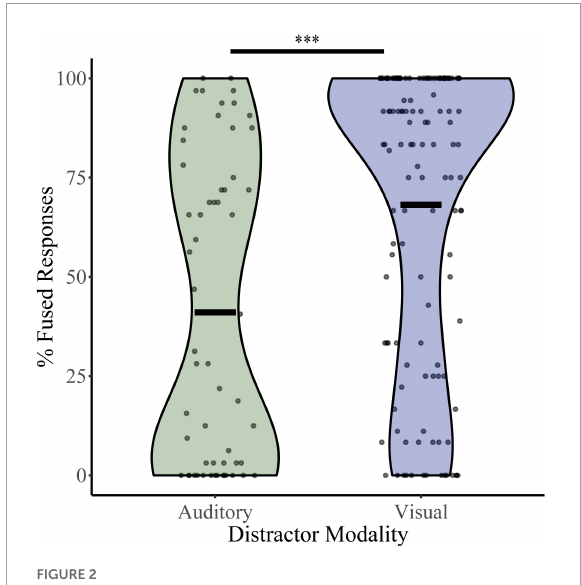
FIGURE2 McGurk fused reports for distractor free blocks. The percent of fused reports (“da” or “tha”) during distractor free blocks is shown for each participant for the visual distractor and auditory distractor groups. Horizontal black bars indicate group averages, and violin plots display the distribution of percent fused reports for each task. ∗∗∗ Indicates p <